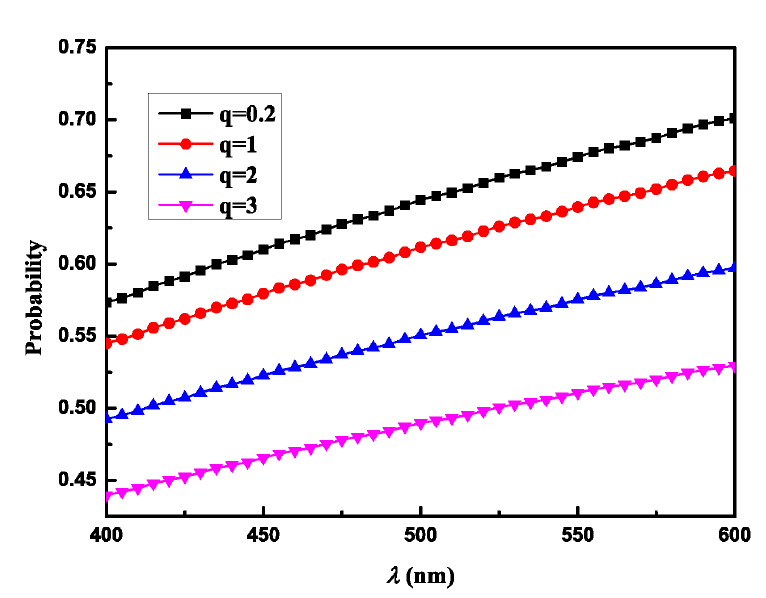
Figure 4. The normalized transmitting probability of the signal vortex modes versus wavelength λ for different values of ellipticity parameter q .